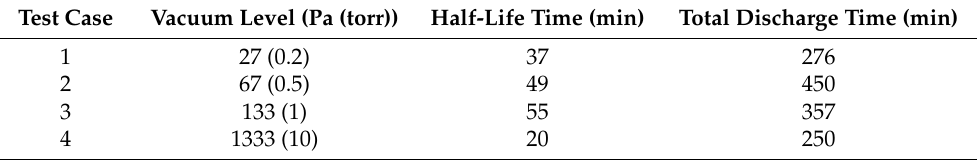
Table 3. Rotor kinetic energy half-life time and total discharge time for all pressure states with the electrical machine